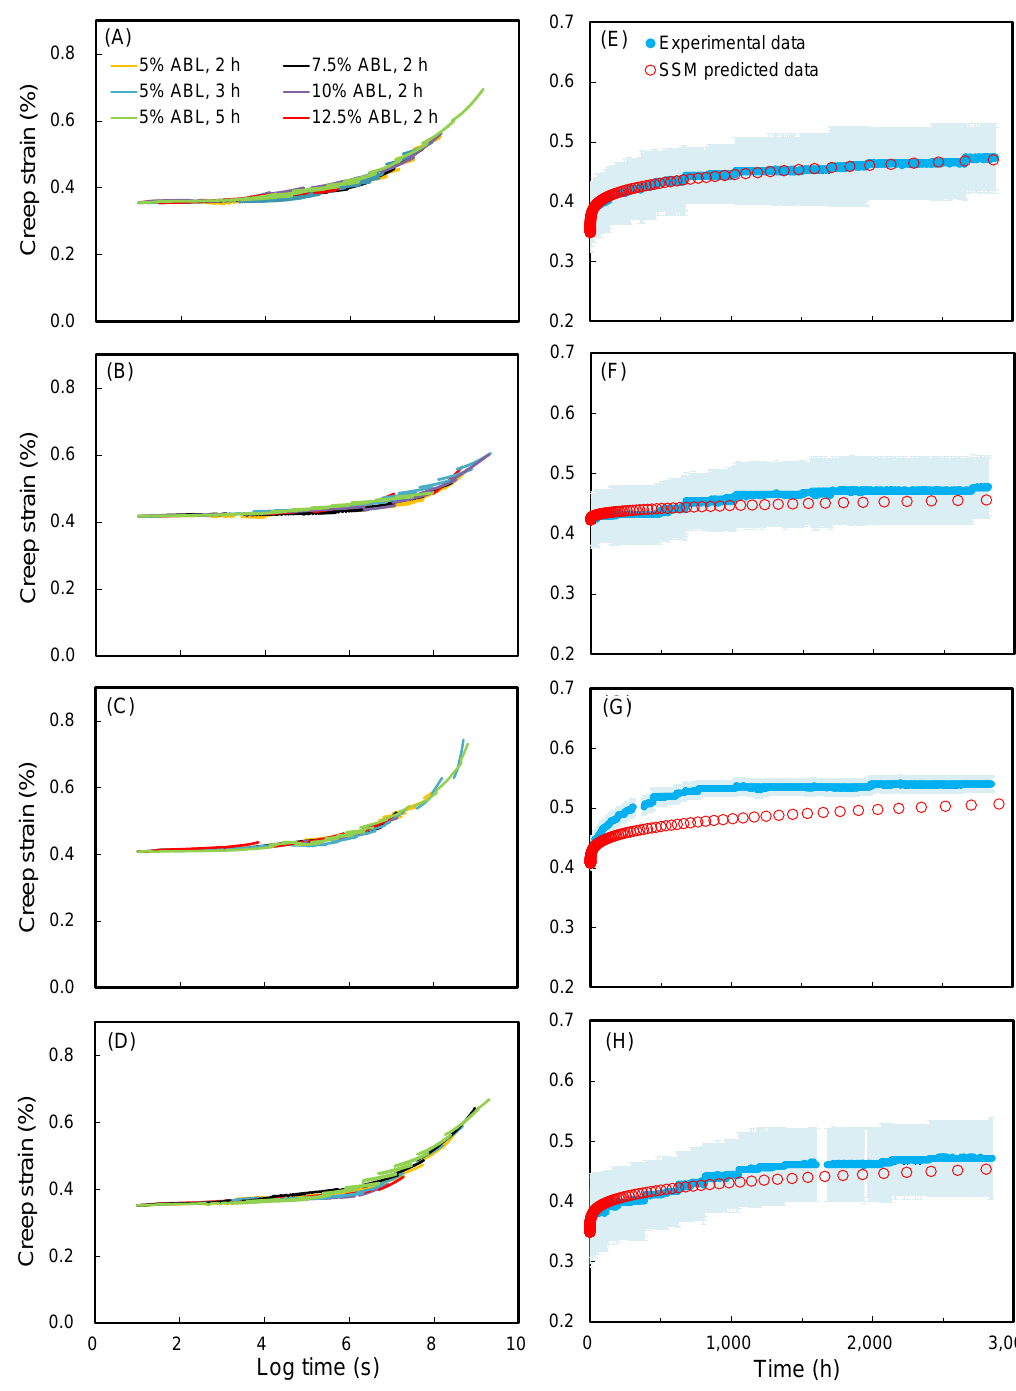
Figure 3. Master curves of ( A ) wood, ( B ) WIC MTMOS , ( C ) WIC TEOS , and ( D ) WIC TTIP , using different SSM testing parameters at a logarithmic time scale. The SSM-predicted creep curve and experimental creep data of ( E ) wood, ( F ) WIC MTMOS , ( G ) WIC TEOS , and ( H ) WIC TTIP at a normal time scale. Experimental creep data are displayed as the mean (blue line) ± SD (light blue ribbon) ( n = 3).